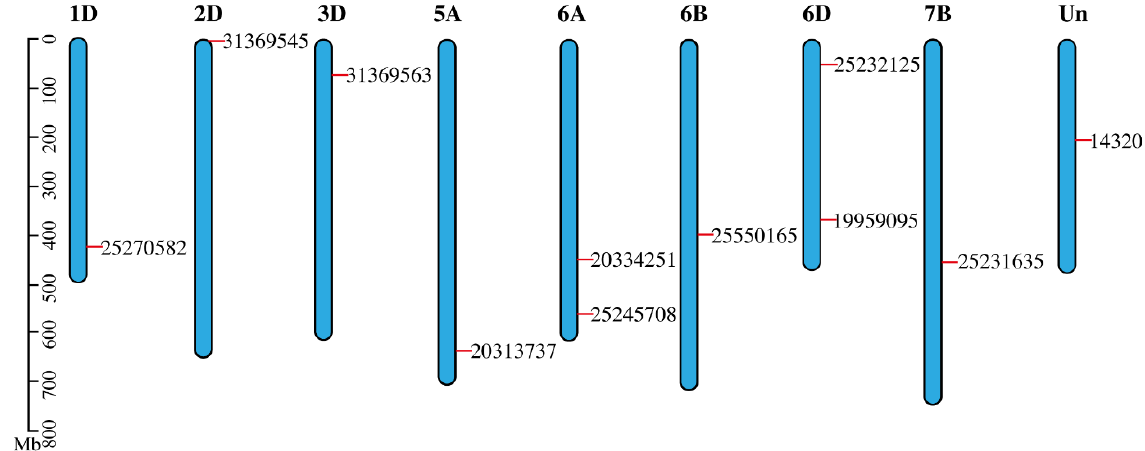
Figure 3 . Chromosomal map depicted the SDGs distribution over their respective chromosomes. Out of all wheat chromosomes, all SDG-bearing chromosomes are included in the map. Gene places on chromosomes were made set according to their genomic locations. The chromosomes were drawn as blue bars.